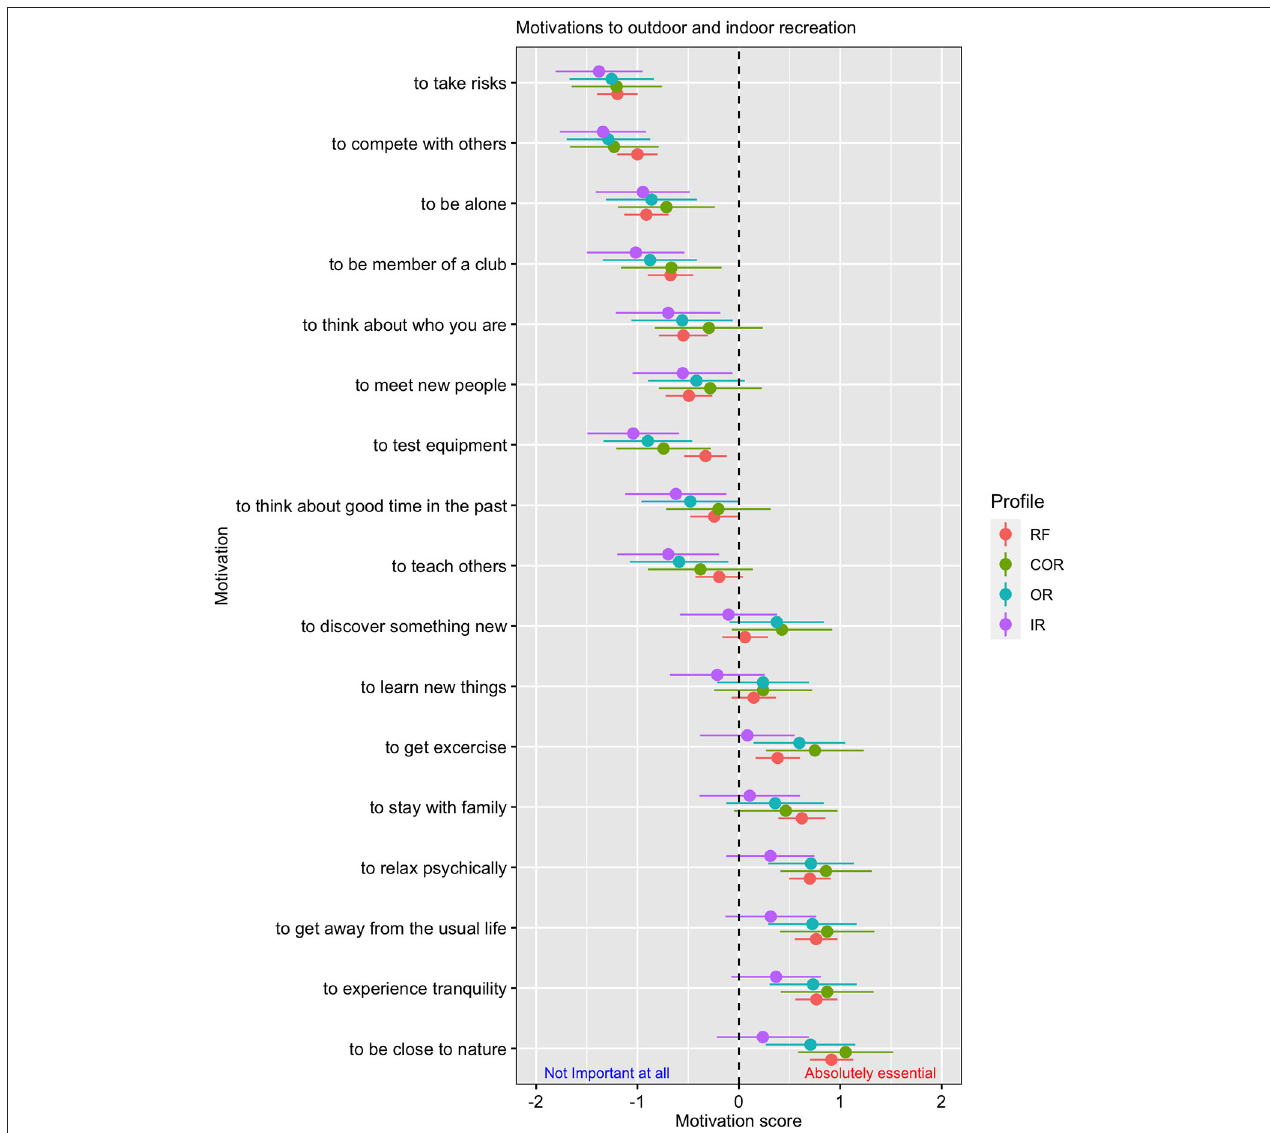
FIGURE 4 | Motivation scores (dot) and Confidence Interval (CI) generated by fitting a General Linear Model (GLM) to each motivation item and for each outdoor and indoor profile: Recreational fishing (RF), consumptive outdoor recreation (COR), outdoor recreation (OR), and indoor recreation (IR). The plot is shown in Likert-type importance/non-importance scale and was scaled from − 2 to 2 for the analysis, where visualization is absolutely essential (2 for the analysis), very Important (1), important (0), not Important ( − 1), and not Important at all ( −